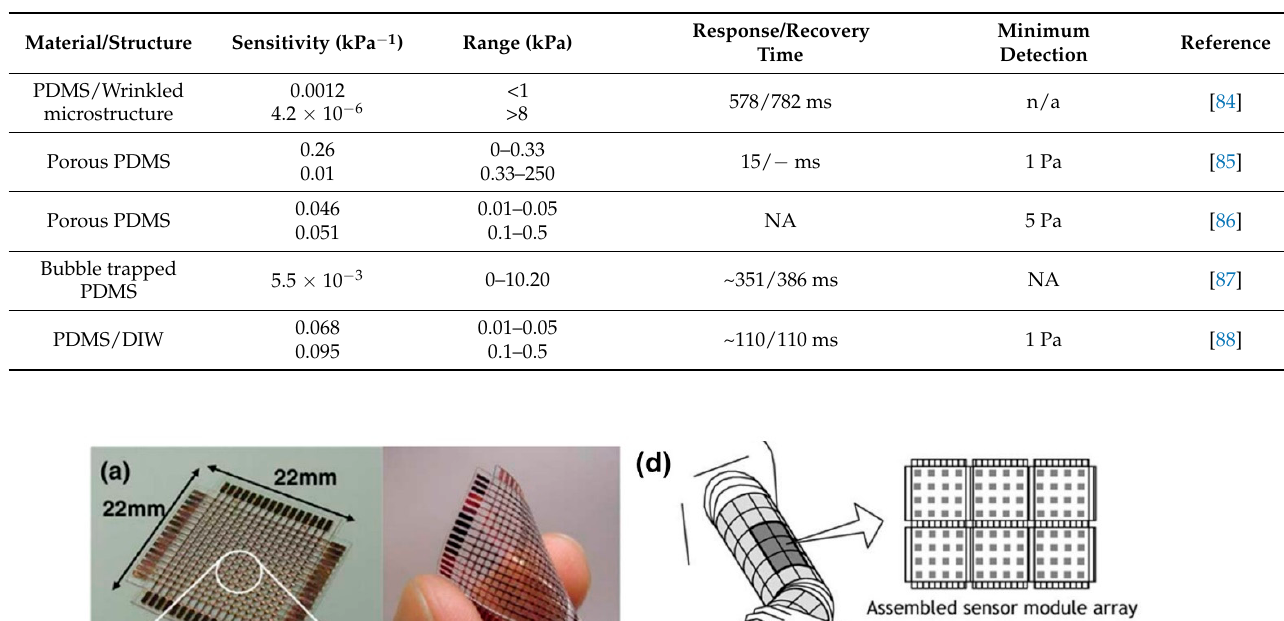
Table 5. Comparison between the capacitive pressure sensors based on PDMS microstructure. DIW indicates deionized water.